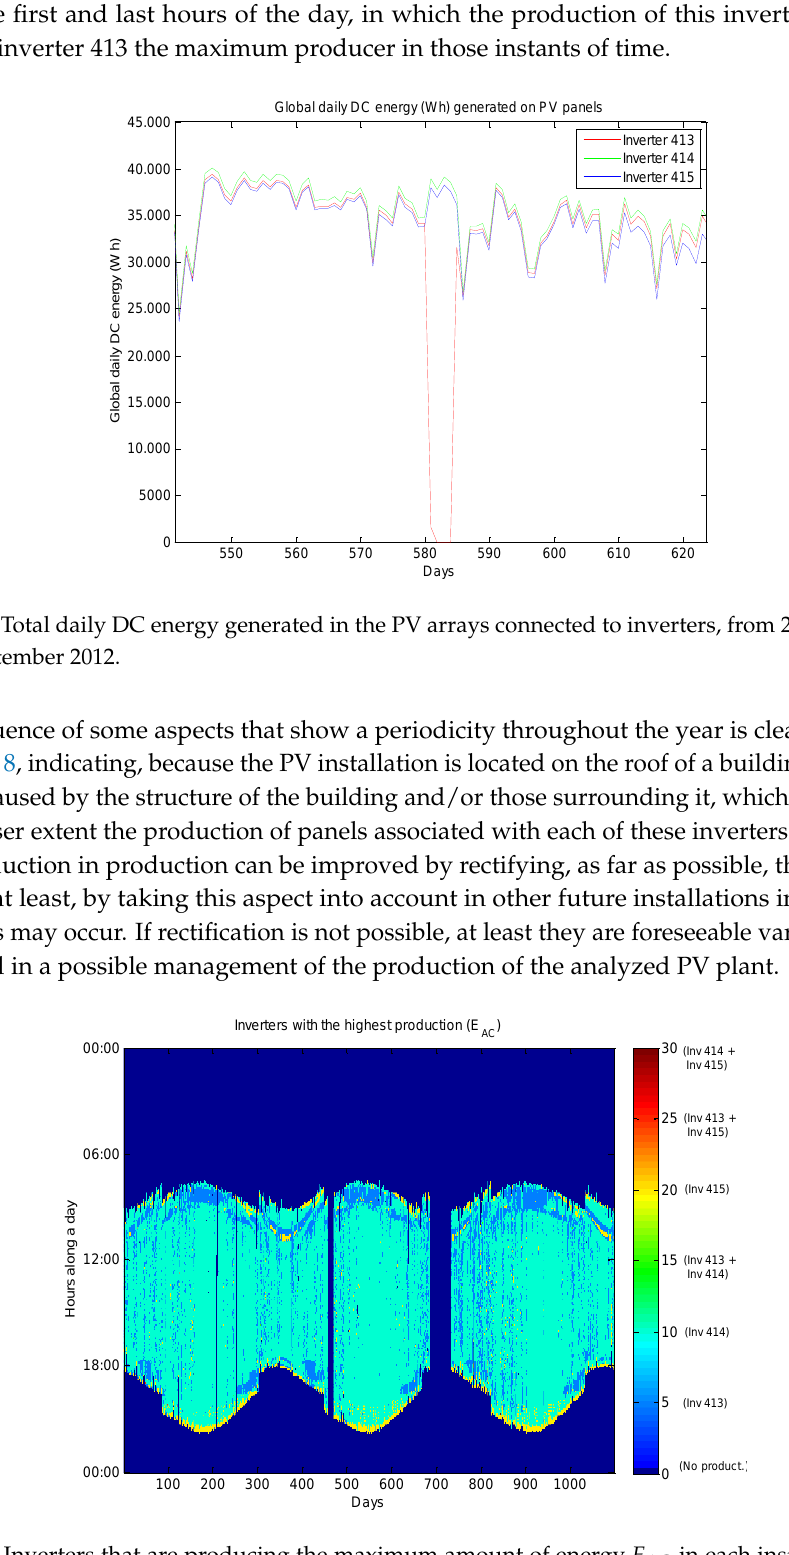
Figure 7. Inverters that are producing the maximum amount of energy E AC in each instant of time from 1 January 2011 to 31 December 2013.